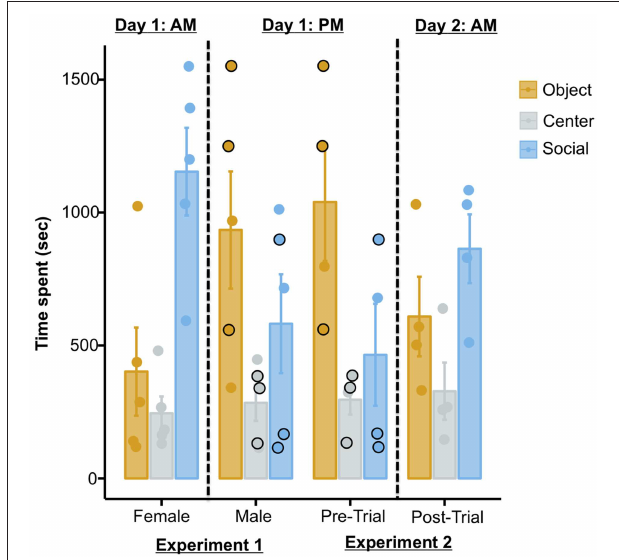
FIGURE 1 | Plot showing the time spent in each chamber in Experiment 1 (left) and in Experiment 2 (right). The temporal sequence in which the two experiments were conducted is relevant only to octopuses that were tested in both experiments (i.e., 3/5 of the sample of Experiment 1 and 3/4 of the sample of Experiment 2, as reported in the original publication). The black outlined dots in the plot refer to the identical performances of three subjects in the second trial of Experiment 1 and in the pre-trial of Experiment 2 (see main text for detail). The plot was produced from raw data provided in the original paper (http://dx.doi.org/10.17632/z9t3x4p5kk.1#folder-73b7a7ef-1c00-